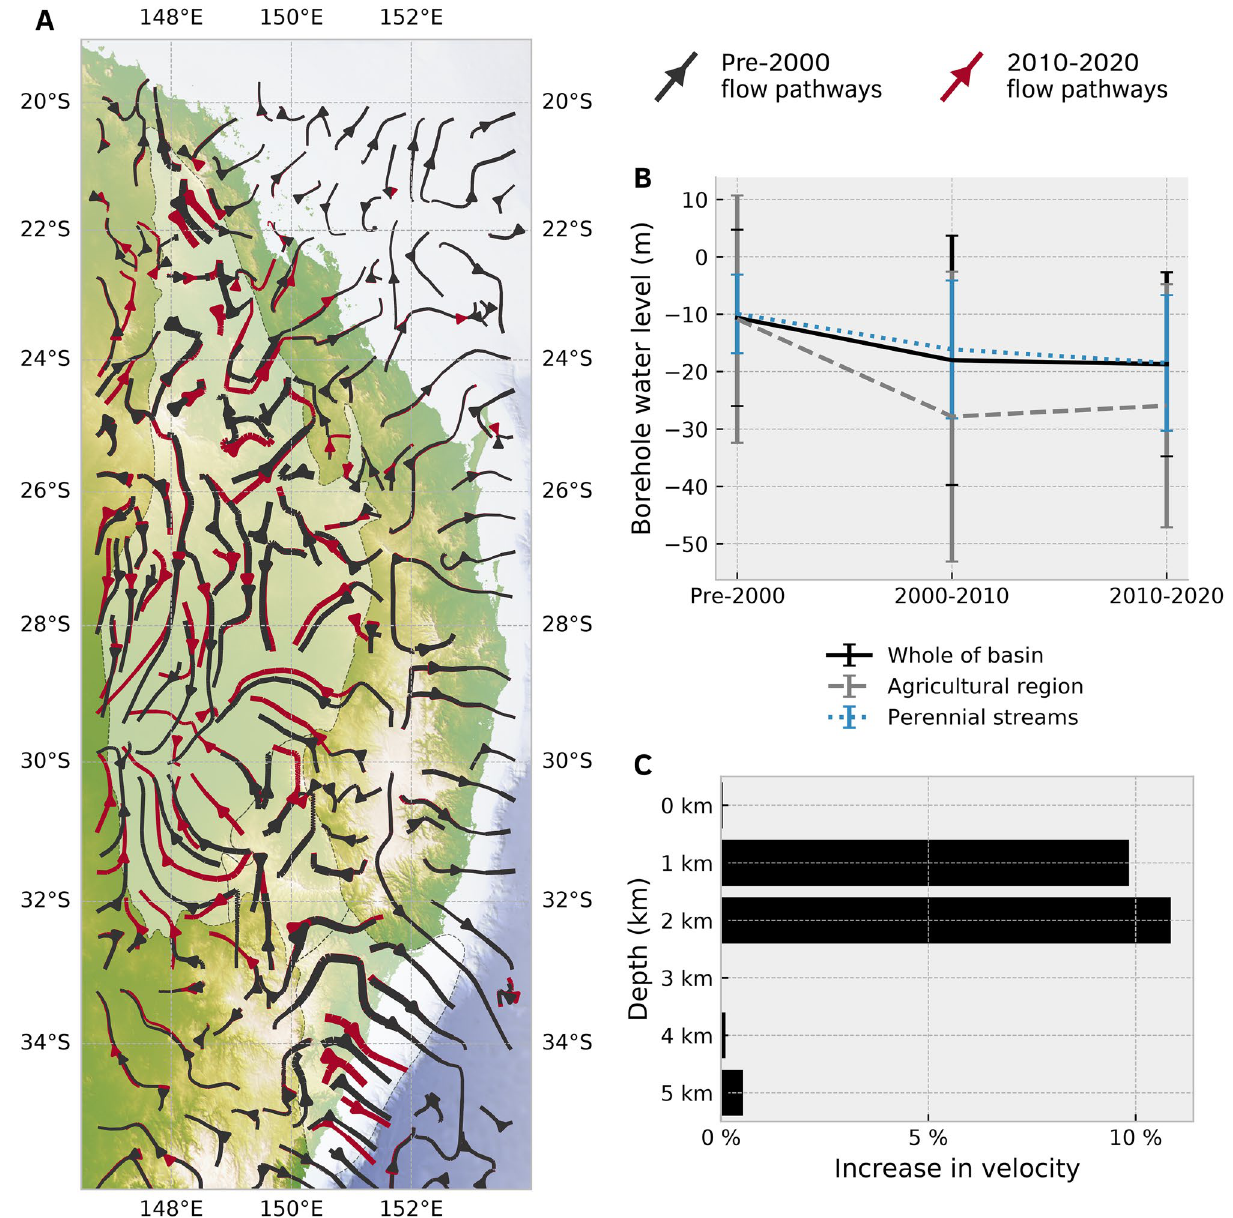
Figure 10. Comparison between regional flow patterns using water table data from pre-2000 to 2010–2020. ( A ) streamlines illustrate the change in regional flow pathways from pre-2000 (dark grey) to 2010-2020 (dark red), where the thickness of each streamline indicates the relative velocity. This map was generated from our models using Cartopy 0.19 (https:// scito ols. org. uk/ carto py). ( B ) Decline in water levels measured in groundwater boreholes from pre-2000 to 2020. The “agricultural region” is the western portion of the model that comprises part of the Great Artesian Basin (west of 150 ◦ longitude between 25–32 ◦ S). ( C ) Flow velocities have increased on average by 10% between 1–2 km depth, which indicates that deeper aquifers of the GAB are recharging alluvial sediments within inland regions to replenish water that has been pumped since